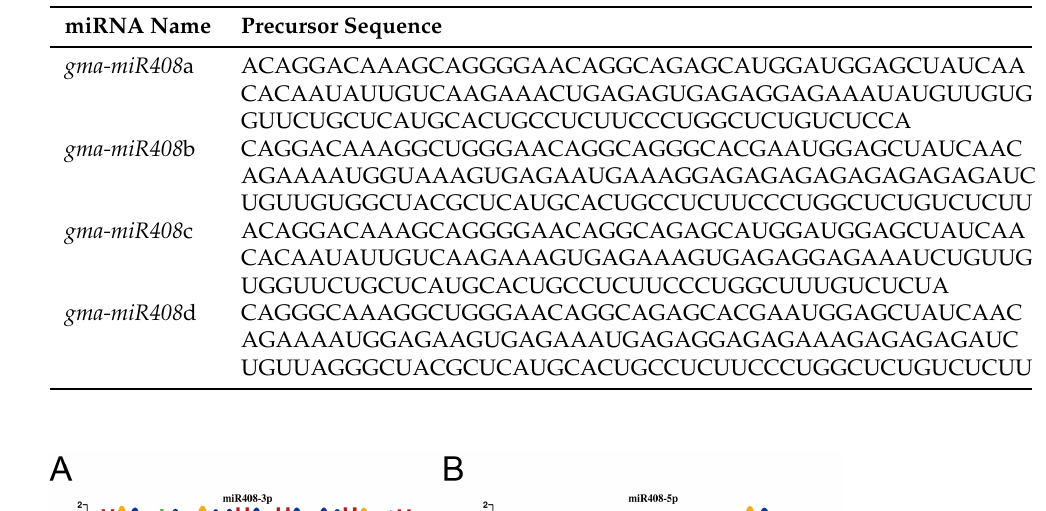
Table 2. Precursor sequences of gma-miR408 family members described in sRNAanno.